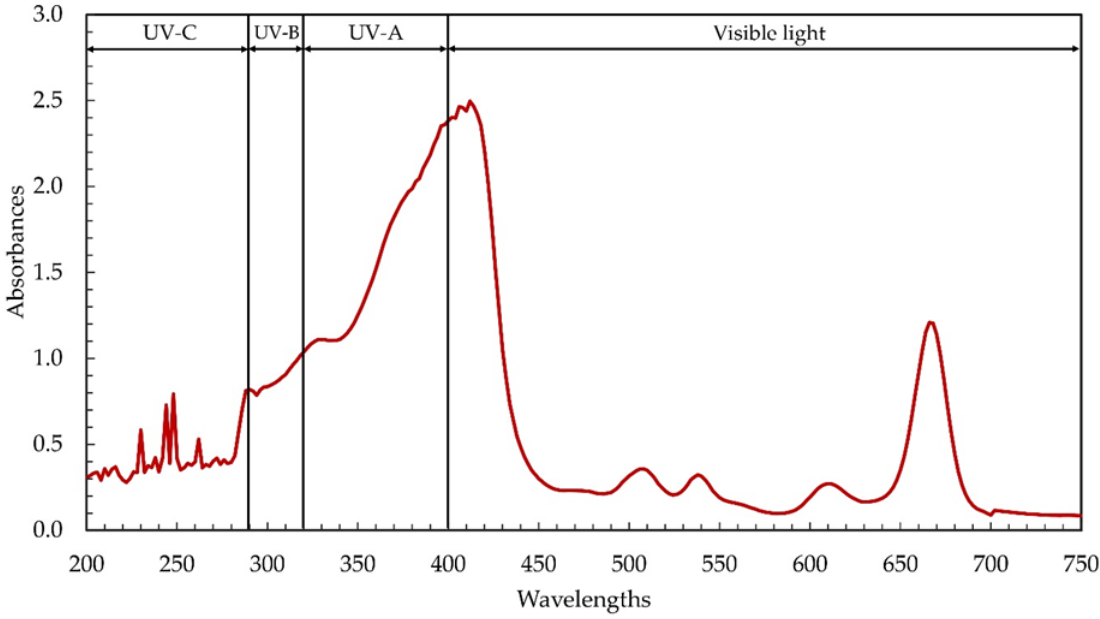
Figure 1. Ultraviolet–visible (UV–Vis) absorption spectra of the ethanolic extract from cyanobacteria, Leptolyngbya sp. KC45. Table 1. Phytochemical composition of the ethanolic extract from cyanobacterium Leptolyngbya sp. KC45. Phytochemicals Concentration Chlorophyll a (mg/g-extract) 40.30 ± 0.21 Chlorophyll b (mg/g-extract) Not detectable Chlorophyll c (mg/g-extract) Not detectable Chlorophyll d (mg/g-extract) Total chlorophylls (mg/g-extract) Carotenoids